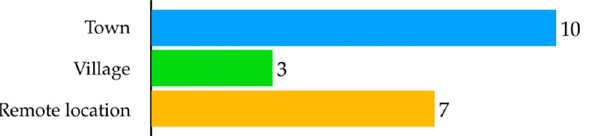
Figure 3. Number of proposed wellness and spa/medical facilities regarding urban/rural context.